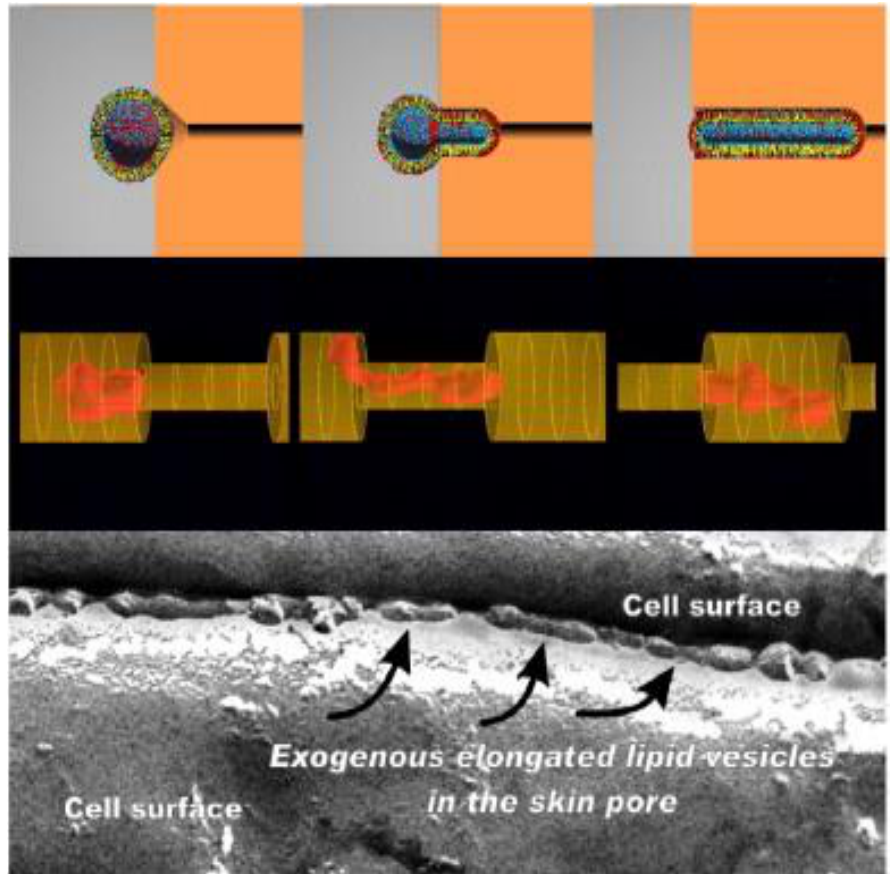
Figure 5. Proposed mechanism of skin penetration by transfersomes. Top: computer simulated distribution of more (red, e.g., a surfactant) or less (blue, e.g., a phospholipid) water soluble molecules with hydrophobic (yellow) chains arranged in a mixed amphipathic spherical bilayer as a function of predefined vesicle shape. Middle: a simulation of a highly deformable, infinitely permeable, non-destructible vesicle forced by a horizontal gradient into a pore with 0.5 smaller diameter. Bottom: an electromicrograph of elongated, deformable vesicles in an inter-corneocyte water-filled channel within the human stratum corneum after an application of a lipid preparation on its open surface. Reproduced from Reference [68] with